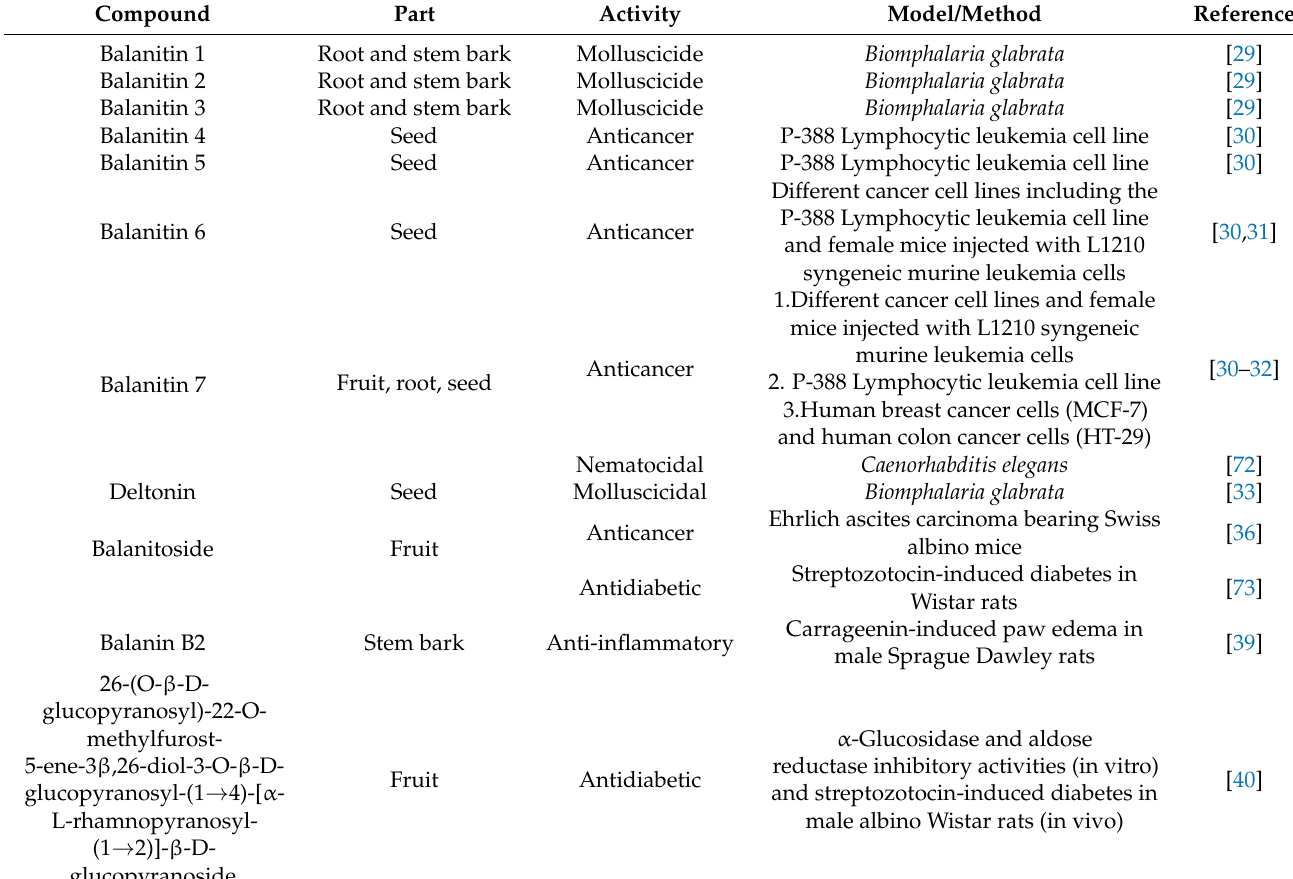
Table 6. Biological activities of compounds isolated from various parts of desert